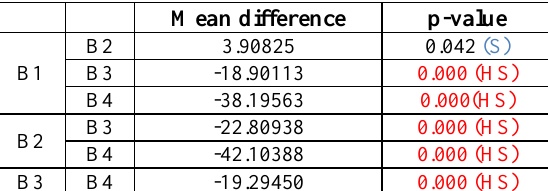
Table 3: LSD test for comparison of significance between subgroups B1, B2, B3, and B4.